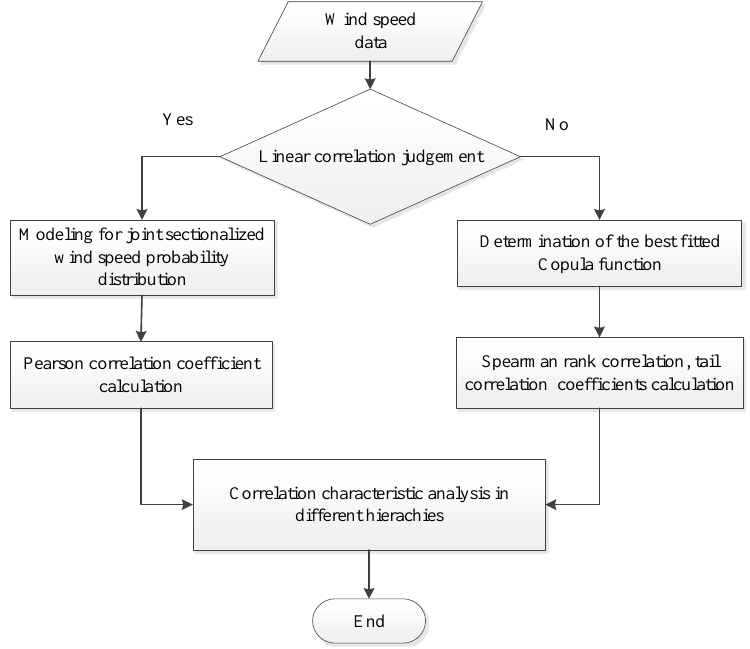
Figure 4. Flow chart of correlation characteristic analysis in different hierarchies.